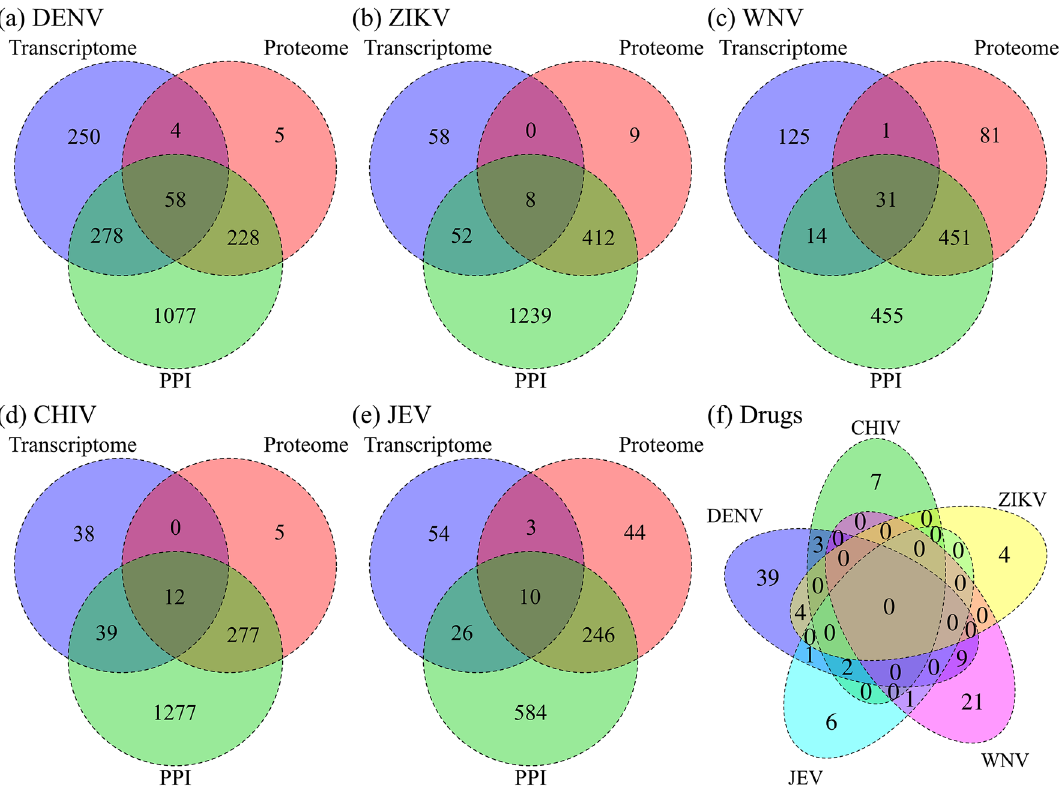
Figure 4. Drug candidates by multiple omics analyses. The numbers of drug candidates identified by the transcriptomic, proteomic and interactomic analyses are shown in blue, orange and green circles, respectively. The numbers of drug candidates that overlap between each analysis type are also shown: ( a ) DENV infection, ( b ) ZIKV infection, ( c ) WNV infection, ( d ) CHIV infection and ( e ) JEV infection. ( f ) The drug candidates of the intersection of the three omics analyses in five viral infections are shown. The numbers of drugs at the intersection of the three layers for DENV, ZIKV, WNV, CHIV and JEV are 58, 8, 31, 12 and 10, respectively. The total number of unique drugs was